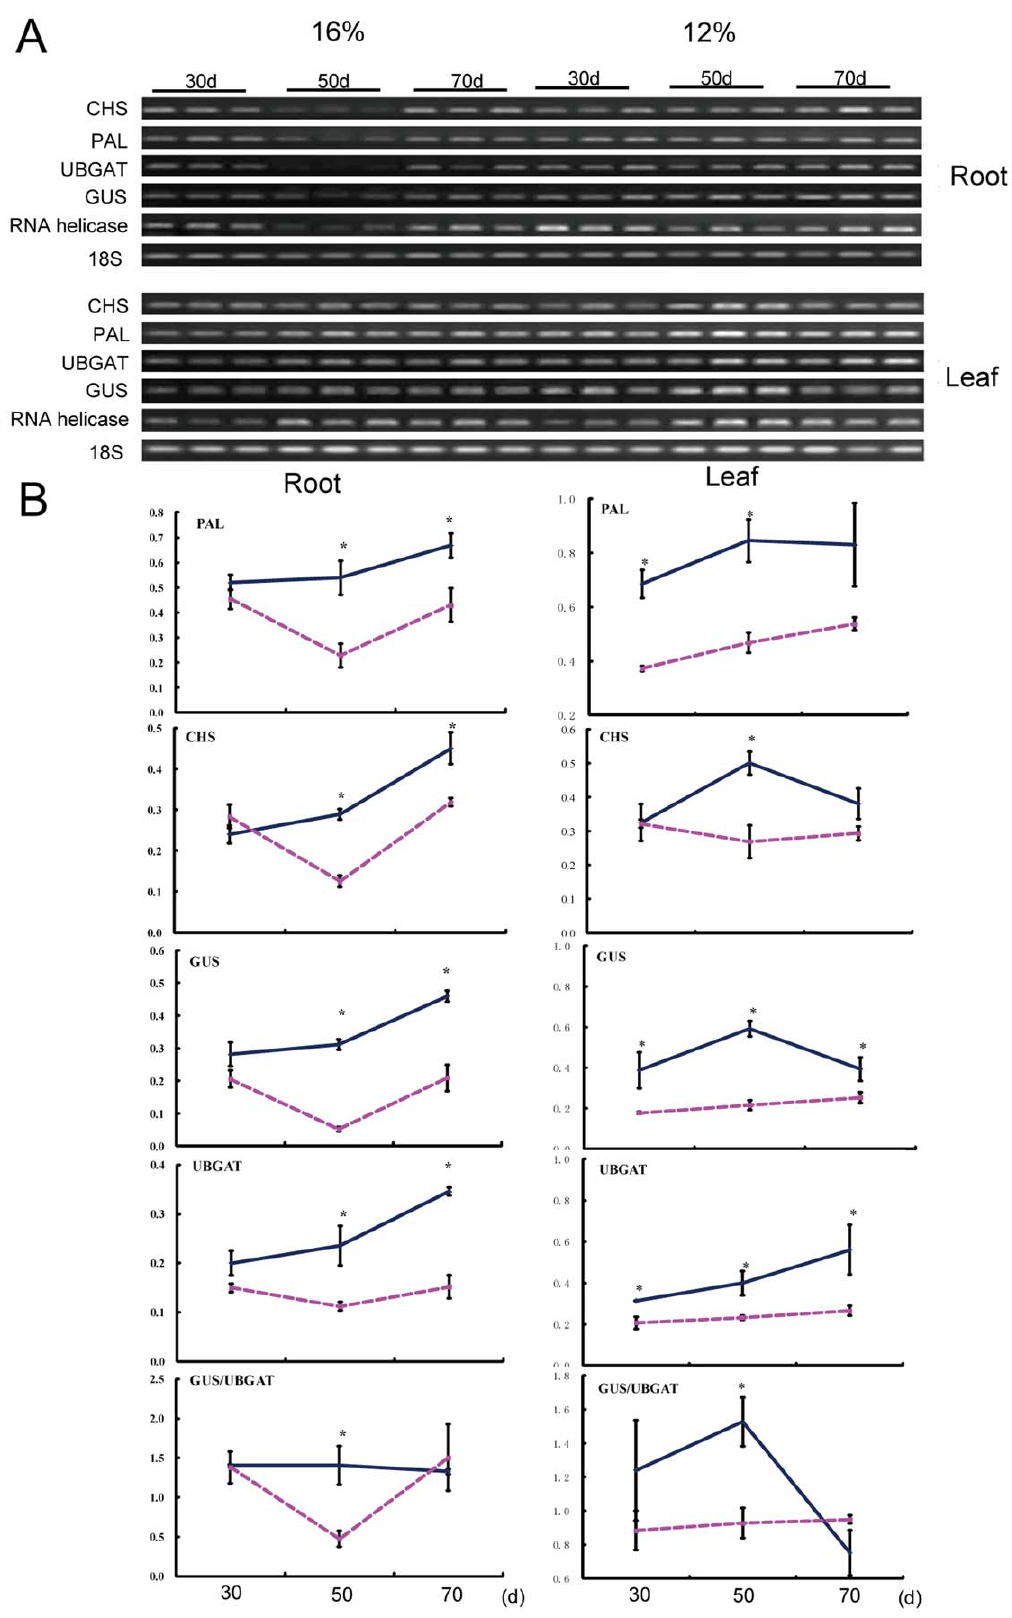
Figure 2. Effects of water deficit on the expression of flavonoid biosynthesis genes in S.baicalensis . A, RT-PCR analysis of the transcript levels of interested genes; B, Quantification of the RT-PCR results. The broken line is for the 16% SWC control and the solid line is for the 12% SWC water stress treatment. Vertical bars indicate the standard deviation of three biological replicates. Asterisks indicate a significant difference at the P , 0.05 level. doi:10.1371/journal.pone.0042946.g002 PLOS ONE |